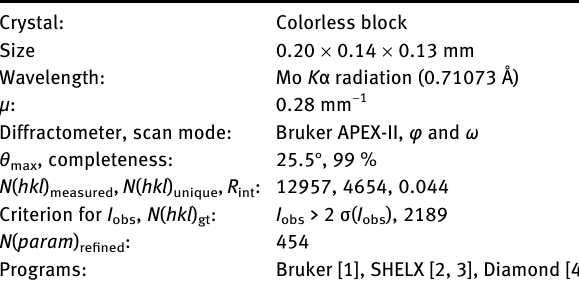
Table 1 contains crystallographic data and Table 2 contains the list of the atoms including atomic coordinates and displacement parameters.